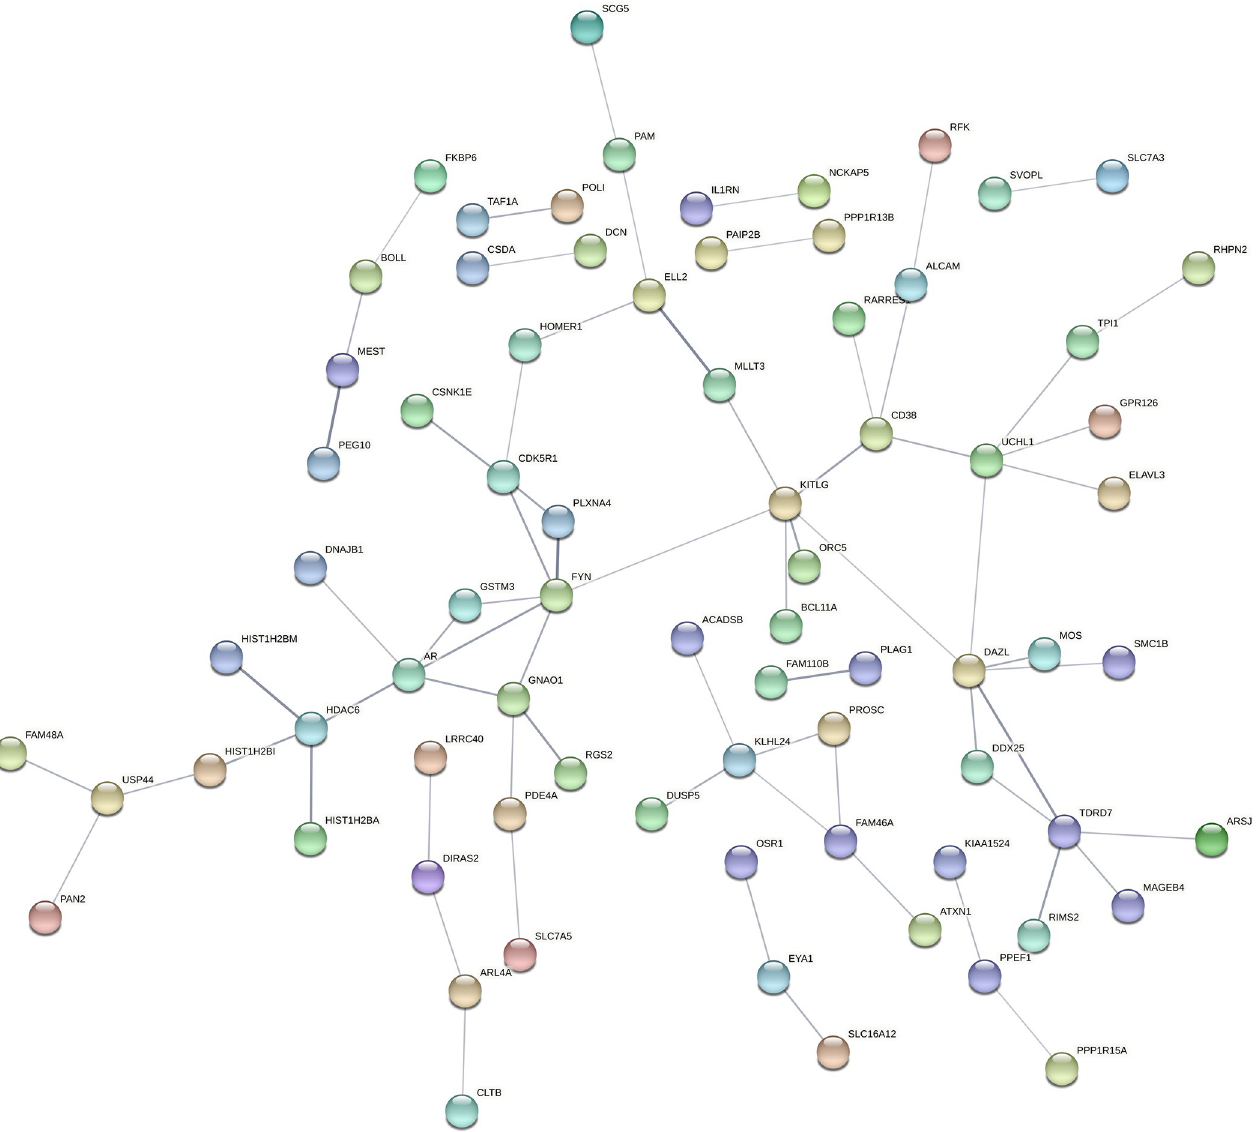
Fig 10. Possible protein–protein connections of non-overlapping differentially expressed genes. STRING analysis of non-overlapping genes expressed differentially in blastocysts derived from asynchronously vs. directly cleaved embryos. Only genes with nodes in the network association are presented. For a better view of the figure, it is highly recommended to use the magnifier